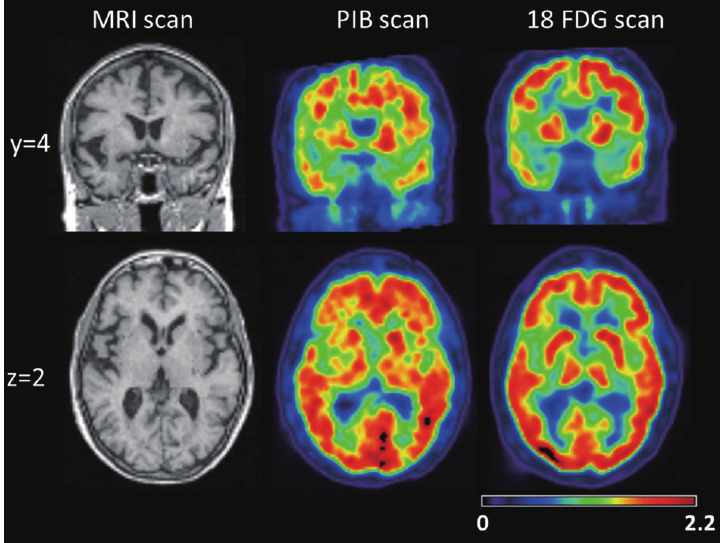
Fig. 1. PIB and FDG-PET obtained at Year 5. PET data were co-registered to the subject’s most proximate T1-weighted MRI and are displayed in neurologic